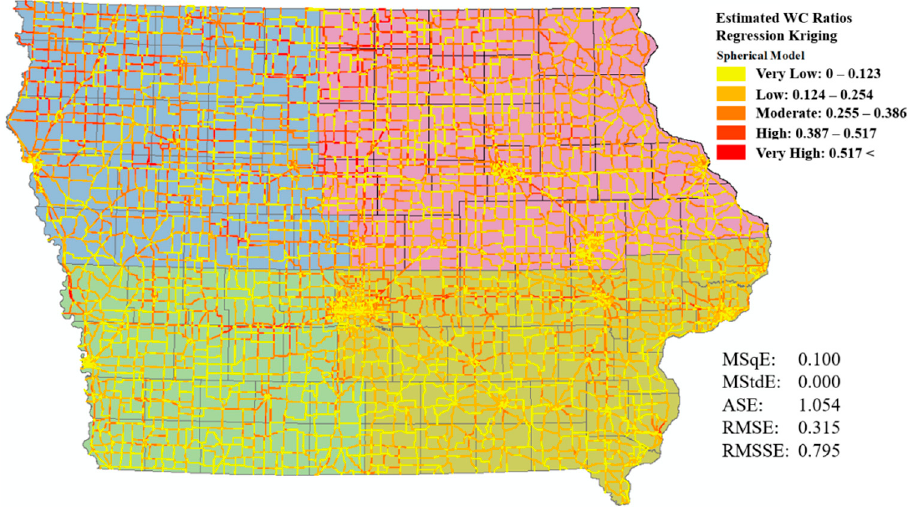
Figure 11. Regression Kriging interpolated WC ratio hotspot map.